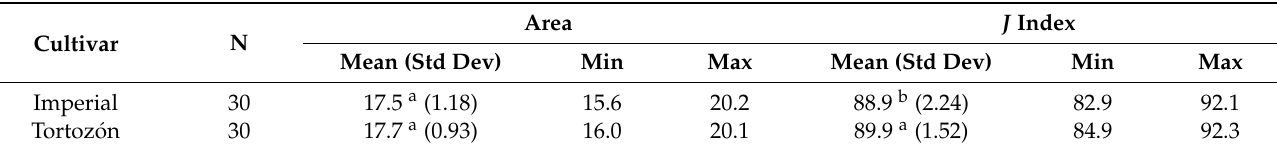
Figure 14. Tortoz ó n. From left to right: A sum of the silhouettes of 30 seeds, a silhouette obtained by the pixel profile of the first image, the Tortoz ó n model, and four representative seeds of this cultivar. Bar represents 1 cm. Table 8. Values of J index in the cultivars Imperial and Tortoz ó n. Superscript letters indicate the results of Scheff é test: the mean values marked with the same letter in the superindex of each column do not differ significantly at p < 0.05. N is the number of seeds analyzed.